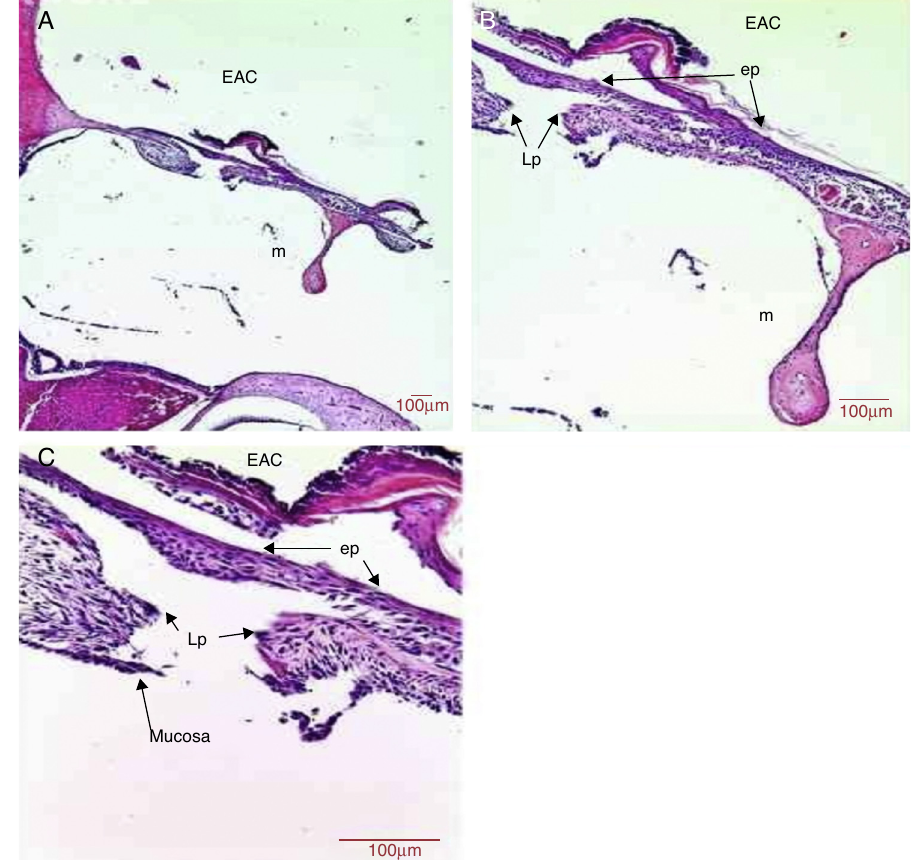
Figure 4 Histological section images of rat TM 5 days after traumatic perforation, stained with HE. EAC, external auditory canal; m, malleus handle; ep, epithelial layer; Lp, lamina propria; mucosa, mucosal layer. Image (A) shows a magnification of 40 × ; (B) 100 × and (C) 400 ×